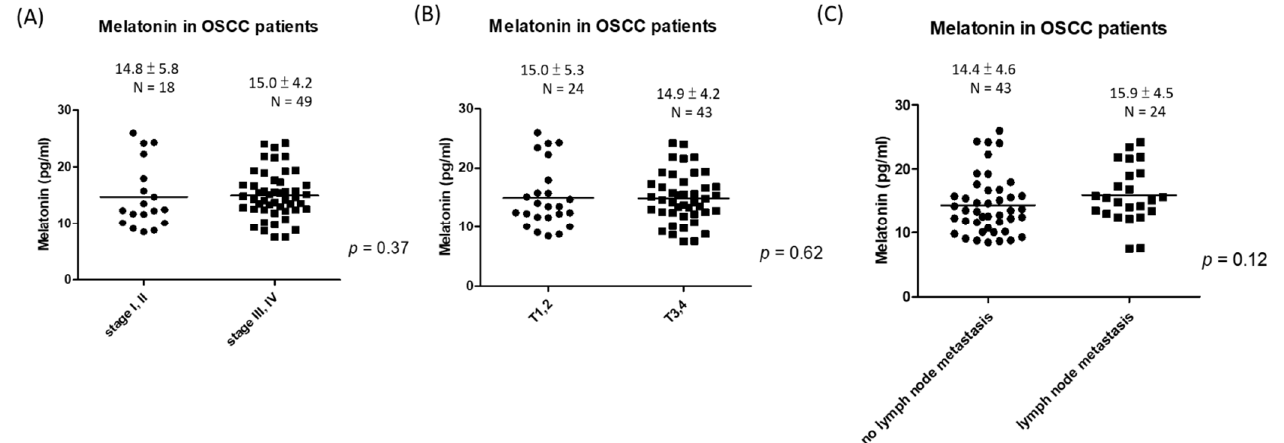
Figure 3. Serum melatonin levels in OSCC patients classified by ( A ) early stages (stage I, II) vs. advanced stages (stage III, IV). ( B ) T status: T1, T2 vs. T3, T4. ( C ) N status: negative vs. positive lymph node metastasis.